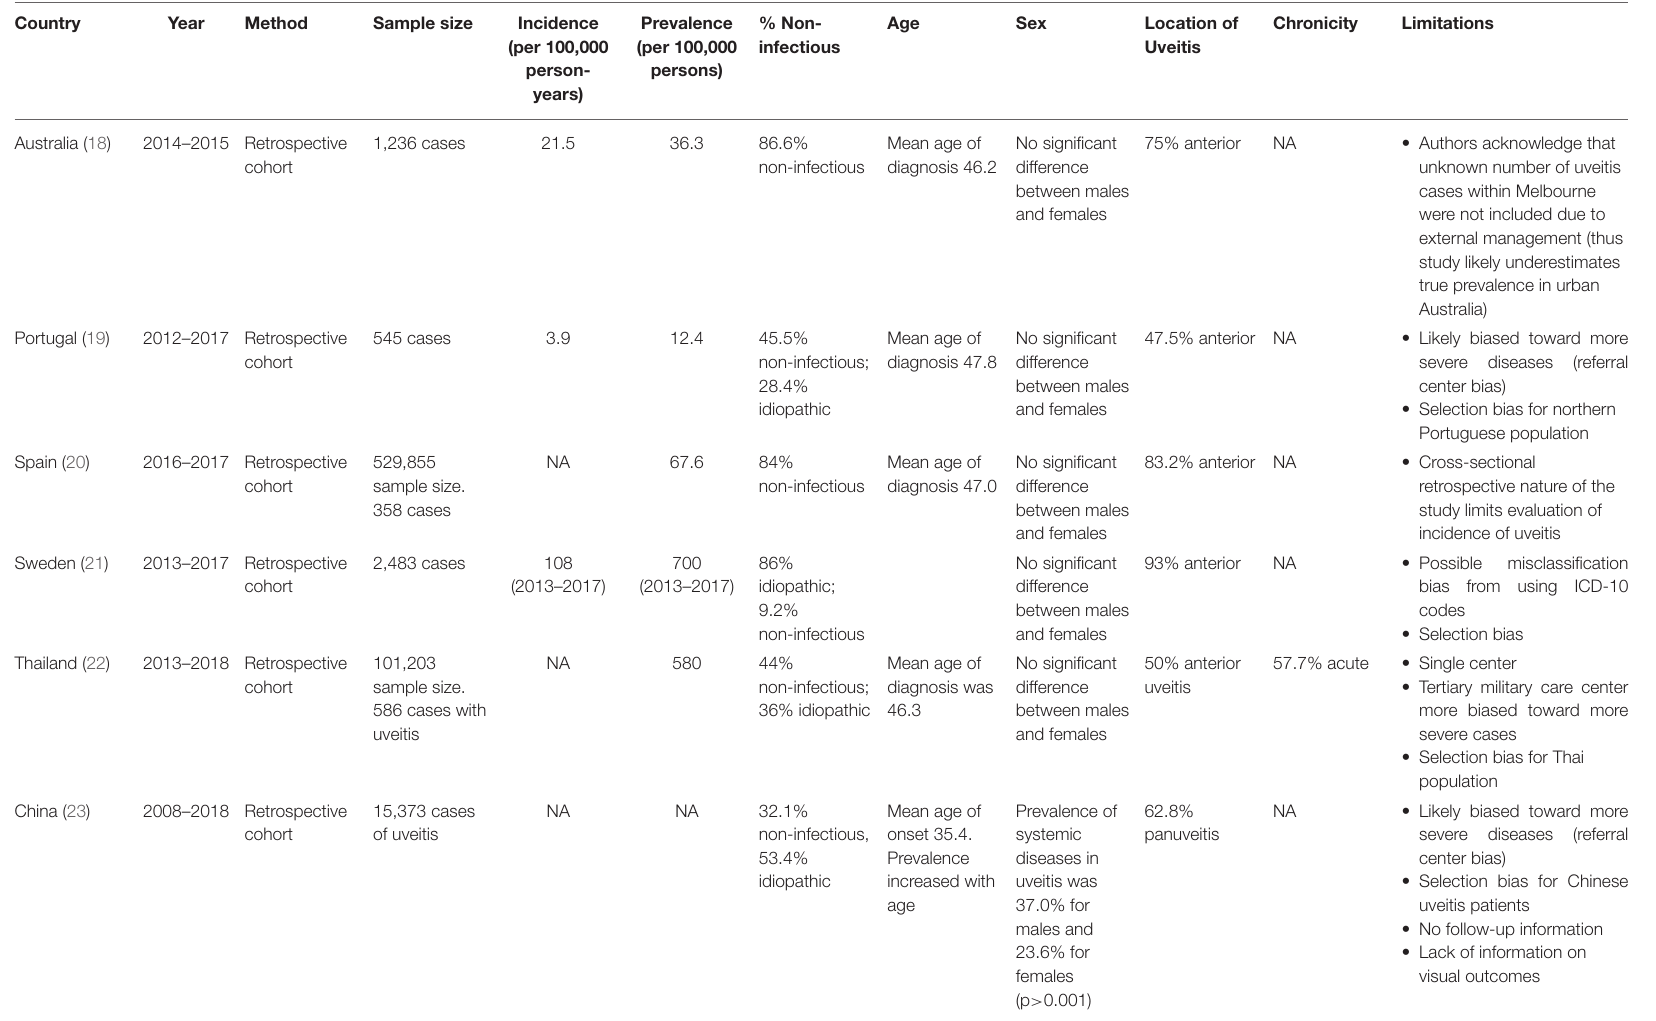
TABLE 2 | Summary of large population-based epidemiologic studies worldwide published since Jan 2019 * .